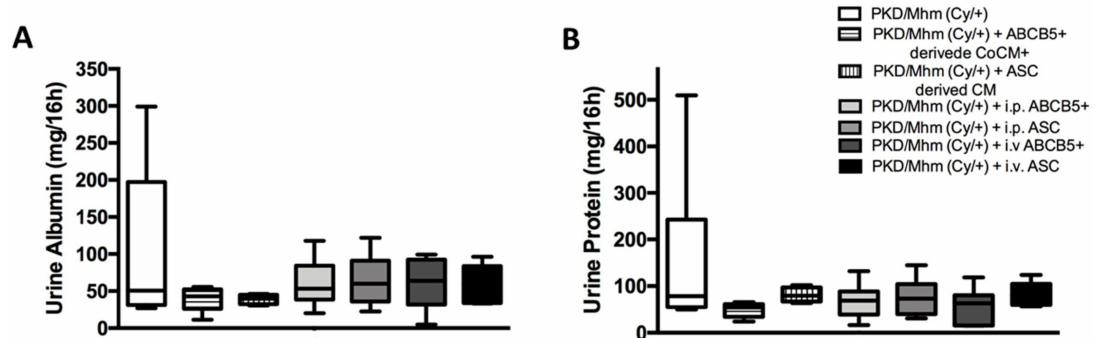
Figure 6. Effect of different treatments on urine parameters in the PKD/Mhm (Cy/+) model (n = 6 in each group). Changes in urine albumin ( A ) and protein ( B ) concentrations. Histograms show means ±